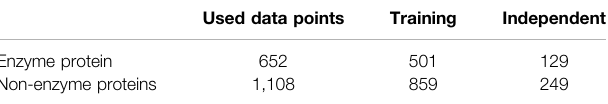
TABLE 2 | Used all model layers and trainable parameters in 2DCNN. TABLE 3 | Statistics of all retrieved Enzyme Protein and Non-enzyme